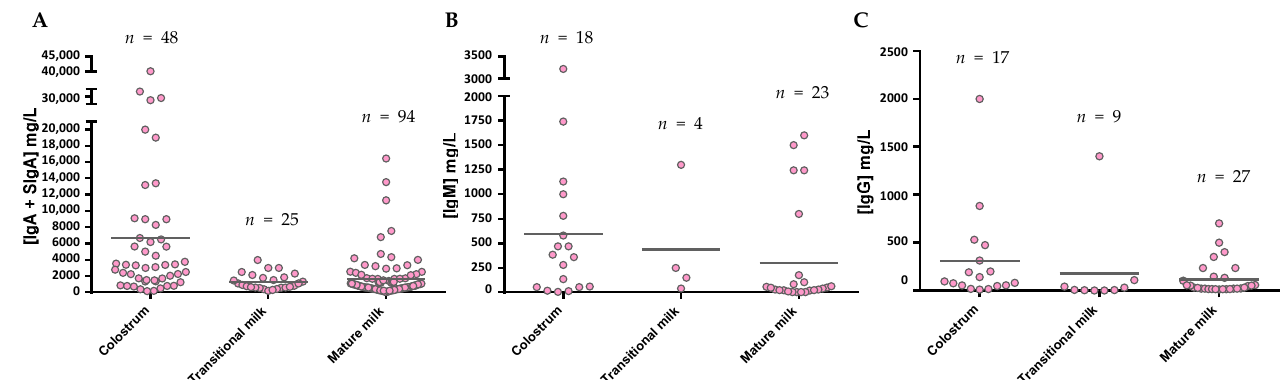
Figure 5. IgA ( A ), IgM ( B ), and IgG ( C ) levels presented in the literature throughout the different phases of breastfeeding. The mean values from each Ig were calculated and shown in the graph using the values provided in the articles for a particular group, independently of the number of samples they are derived from. Figure A takes into account both the determinations obtained from IgA studies and those that claim to measure SIgA specifically.